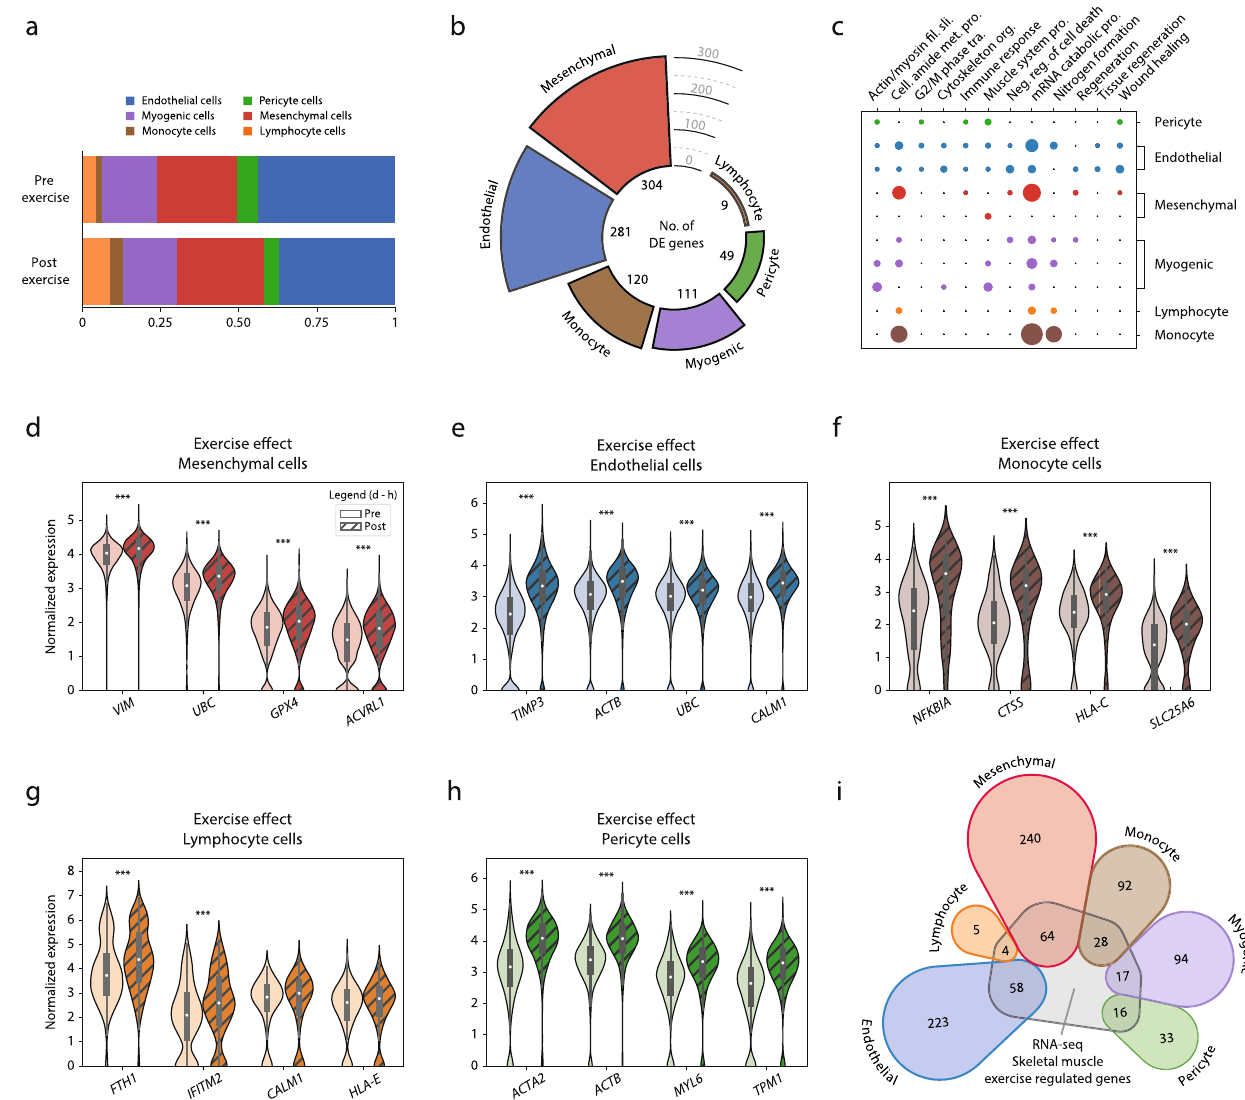
Fig. 3 Transcriptional response to a single bout of exercise across cell types. Exercise effects detected by scRNA-seq analysis of the human skeletal muscle. a Cellular composition analysis of samples before (pre-exercise) and three hours after (post-exercise) a single bout of exercise. b Differential expression analysis across cell types after a single bout of exercise. Color coding represents cell-type, and bar height denotes the number of exercise- regulated genes. In total, 874 (535 unique) genes were upregulated by exercise, with mesenchymal cells having the highest number (304), followed by endothelial cells (281) and monocytes (120). In contrast, only 9 genes were found to respond to the exercise stimulus in the lymphocyte population. c Gene-ontology analysis revealed that most biological processes regulated by exercise were cell-type speci fi c, with a small number of processes similarly regulated in most cell types ( “ mRNA catabolic process ” and “ nitrogen formation ” ). Color coding represents different cell-type, and a larger dot radius denotes a more signi fi cant gene ontology ( fdr < 0.05 ) . d – h Normalized expression level of representative genes for each cell type that were differentially expressed after exercise. The data in boxplots nested within violin plots are expressed as median, interquartile range, minimum and maximum values. *** fdr < 10e − 5. i Genes that were signi fi cantly regulated by exercise in the current scRNA-seq experiment were compared with differentially expressed genes after exercise using RNA-seq from whole muscle. Color coding represents different cell-type, and numerical value denotes the number of differentially expressed genes shared by both methods or those exclusively detected by scRNA-seq. Approximately 25% of the genes detected by scRNA- seq were also identi fi ed using RNA-seq and this was consistent across all cell types. Normalized expression refers to log(1 + x) if not stated otherwise. Complete exercise-differential expression and ontology analysis can be found in Supplementary Data 5 – an in fl ammatory response and cellular stress reactions to genes after exercise (Fig. 3b). Ontologically, the monocytes exercise (Fig. 3f). Lymphocytes differentially expressed 9 genes presented a generic response to exercise, with terms such as after exercise (Fig. 3b). Ontologically, the lymphocyte cells “ amide biosynthetic process ” ( fdr < 0.001), “ protein targeting ” solely enriched for generic terms, suggesting an absent exercise- ( fdr < 0.001), and “ peptide metabolic process ” ( fdr < 0.001) speci fi c response. The genes regulating the ontological enrich- (Fig. 3c). When considering the differential expression of ment were overall generic and lacked established biological single genes, the monocyte population signi fi cantly expressed functions in the literature (e.g., FTH1 , IFITM2 , CALM1 , and NFKBIA , CTSS , HLA-C , and SLC25A6 after exercise, suggesting HLA-E ) (Fig. 3g).